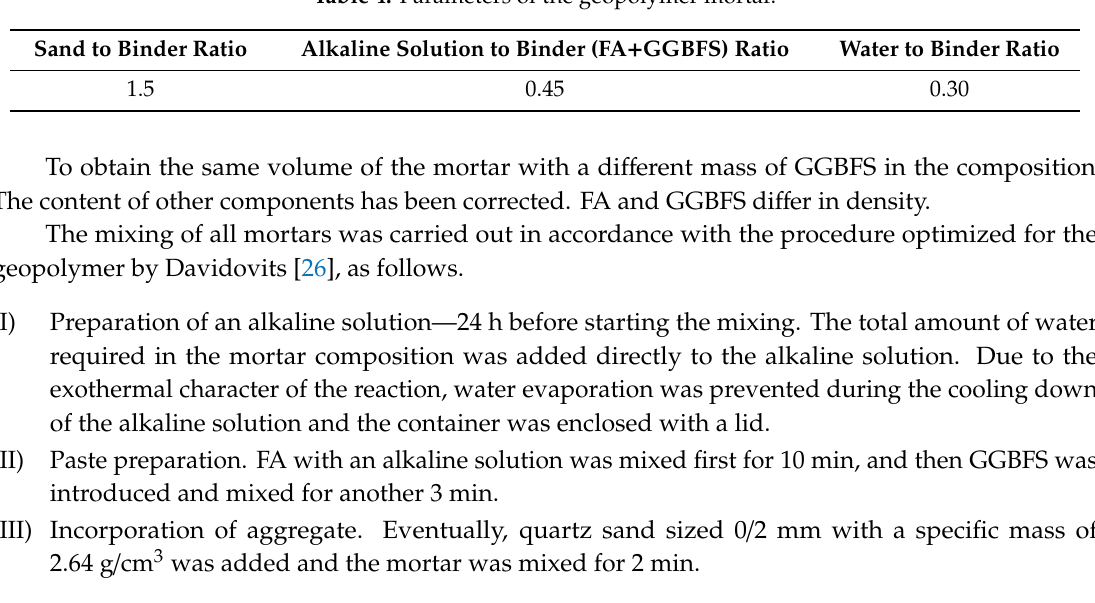
Table 4. Parameters of the geopolymer